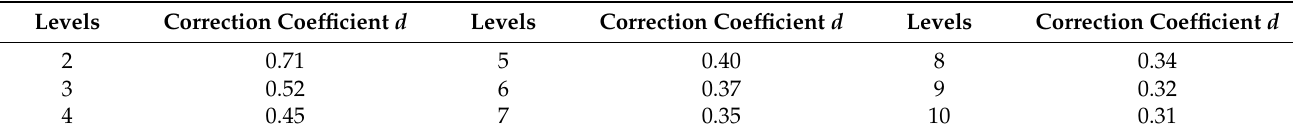
Table 3. The correction coefficient.